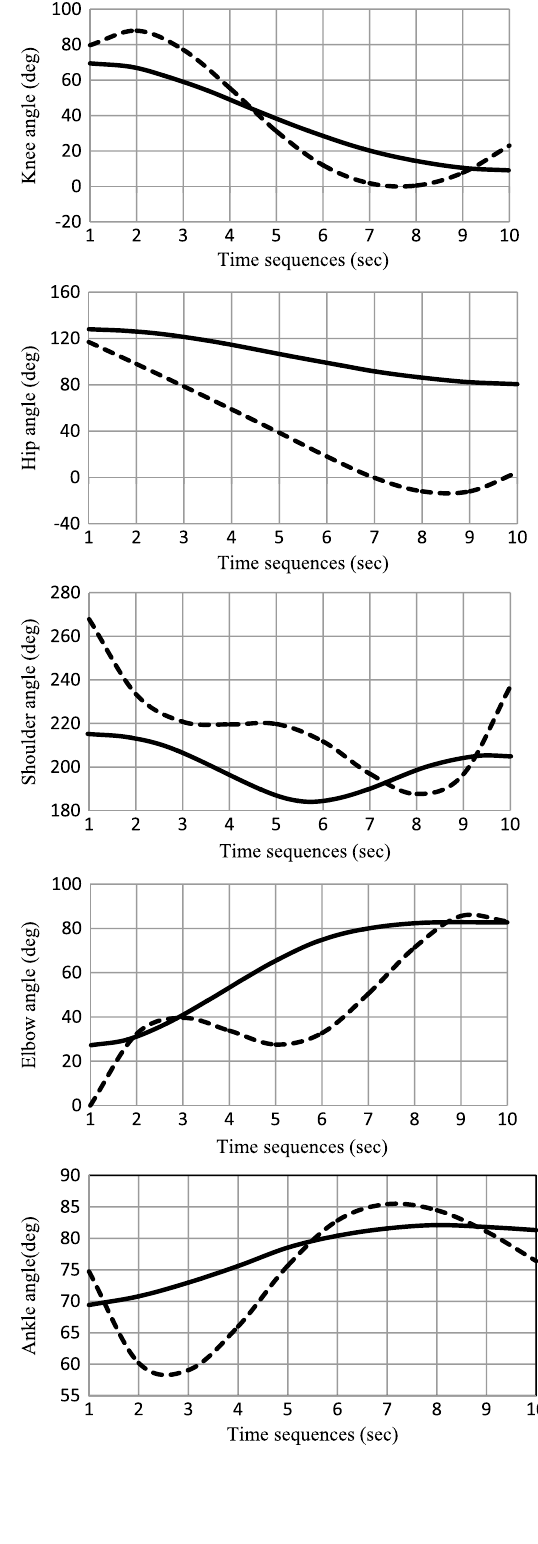
Fig. 8. The optimal profiles of the joints angles in comparison with experimental results. The solid and broken lines are experimental and predicted results respectively. The vertical axis are angles in degree and the horizontal axis are time sequences in 0.25sec